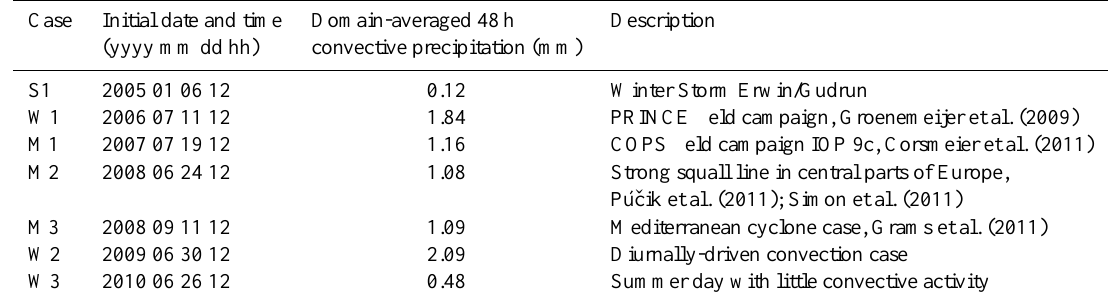
Table 1. List of selected